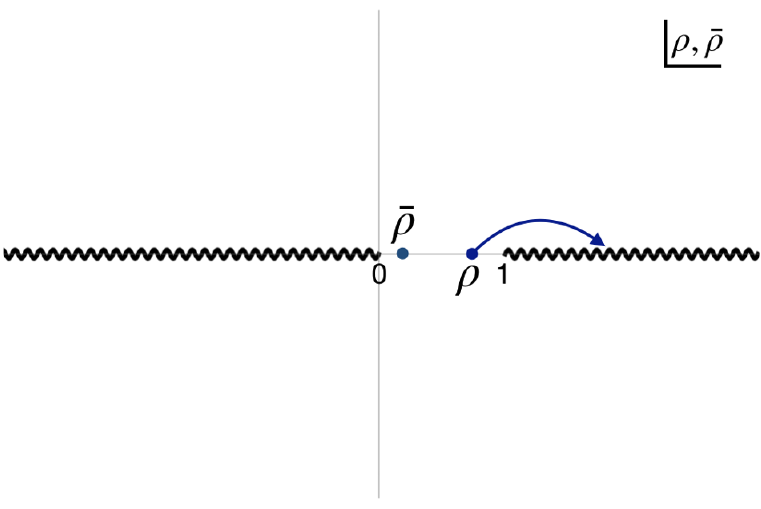
Figure 4 . Analytic structure of G ( (cid:26); (cid:22) (cid:26) ) | branch cuts appear only when two operators become null separated. The Regge limit described above can be reached by analytically continuing (cid:26) along the blue